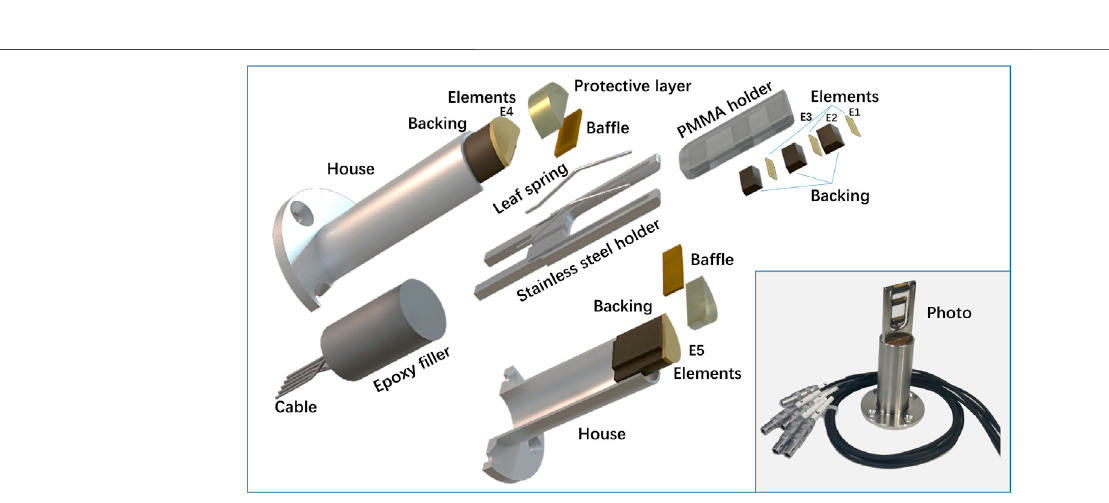
FIGURE 5 | Exploded device structure of the ultrasonic